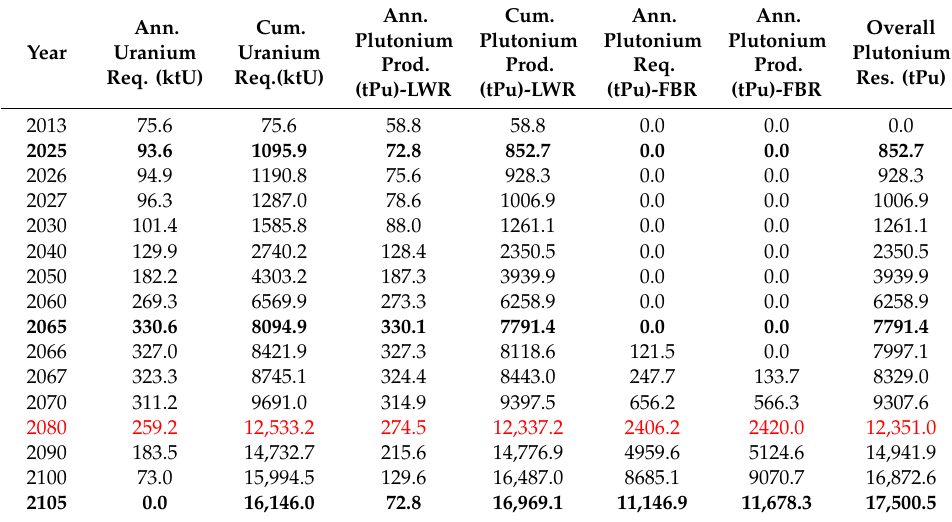
Table 2. Uranium requirements and plutonium production and requirements for scenario S1, sub scenario A.